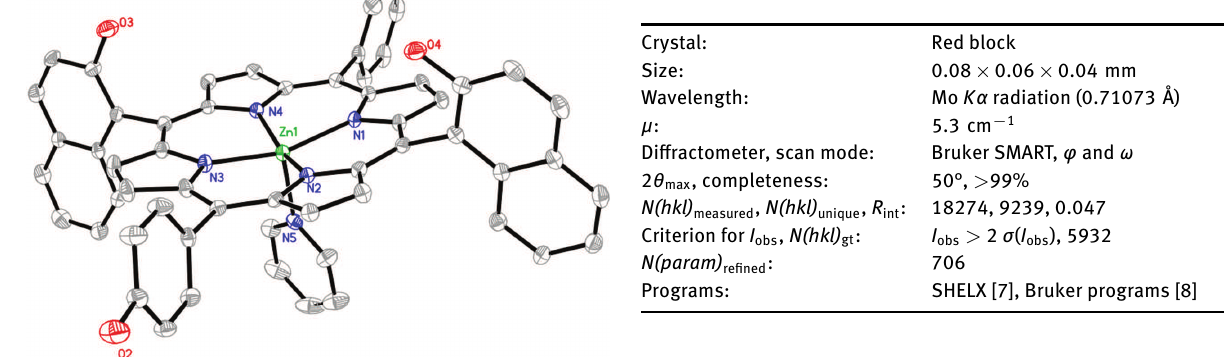
Table 1: Data collection and